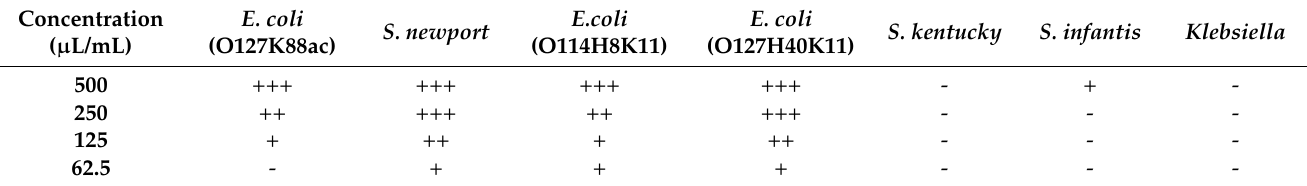
Table 2. Sensitivity of strains to lavender essential oil evaluated using the disc diffusion method. Classified as: not sensitive (-) for diameters smaller than 8 mm; sensitive (+) for diameters from 8 to 14 mm; very sensitive (++) for diameters from 15 to 19 mm and extremely sensitive (+++) for diameters over 20